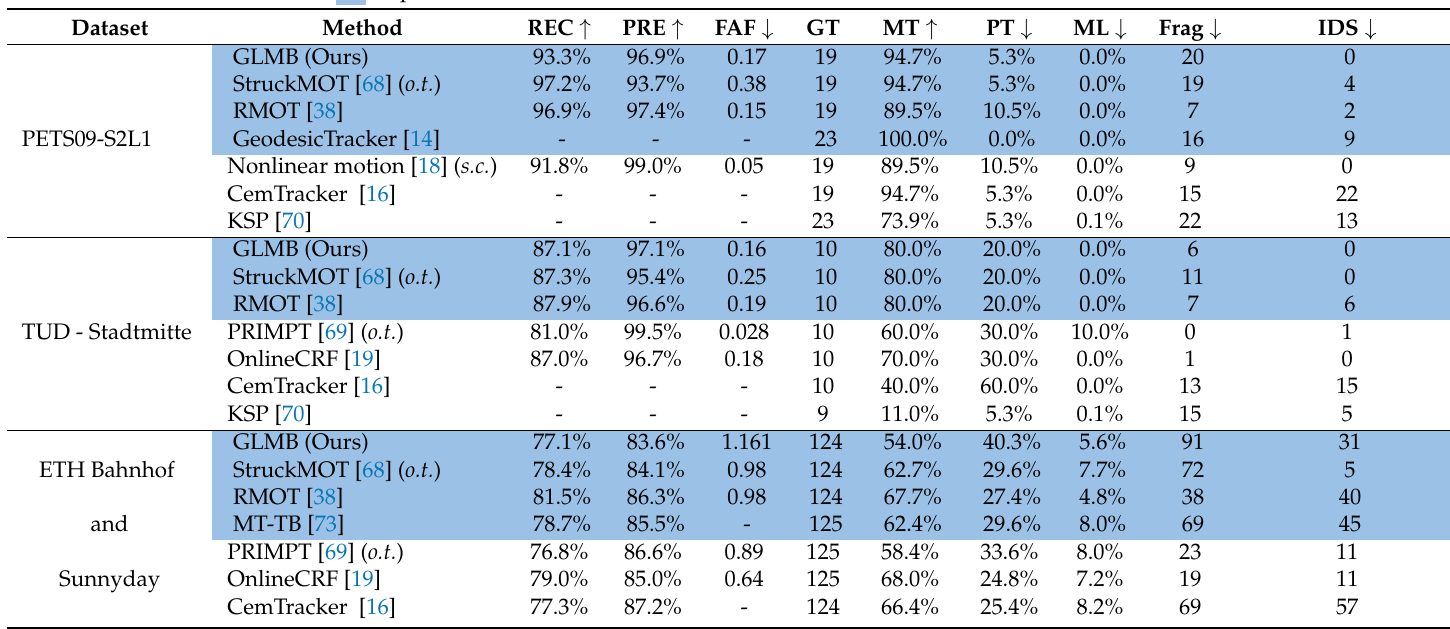
Table 2. Comparative results for PETS2009-S2L1V1, TUD-Stadtmitte and, ETH Bahnhof and